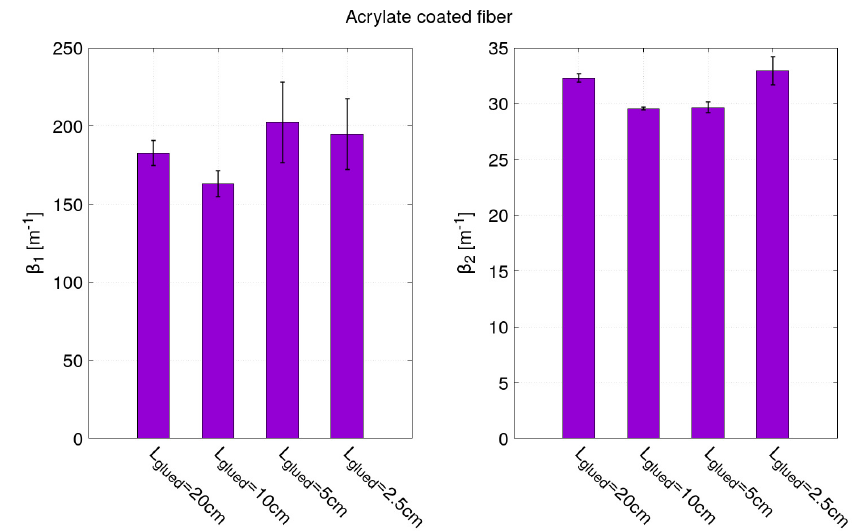
Figure 12. Fitting parameters β 1 and β 2 of the strain profiles obtained by optical fibers with acry- late